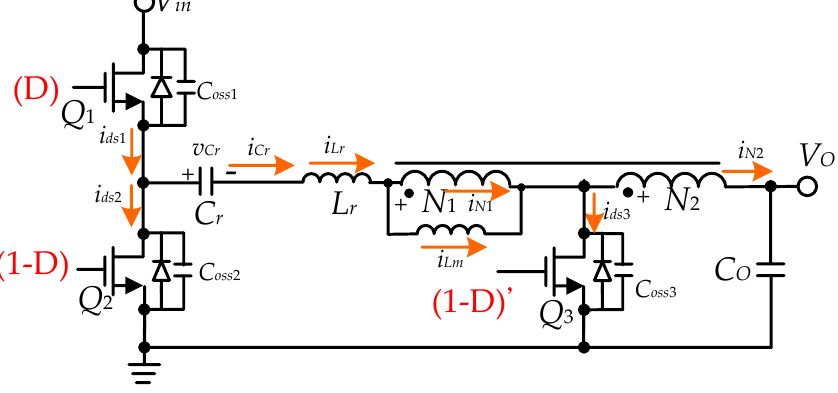
Figure 1. The previous high step-down converter with COT control.